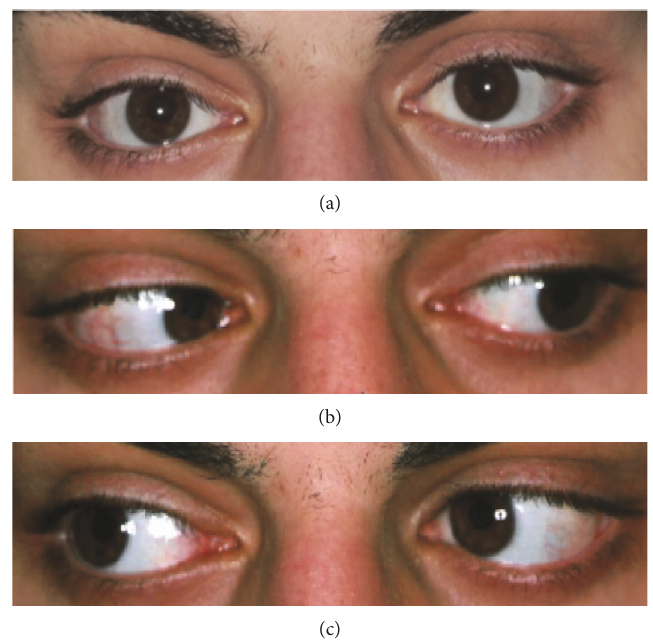
Figure 2: Patient 3, 12 months after Y-split recession. At near fi xation (a), left gaze (b), and right gaze